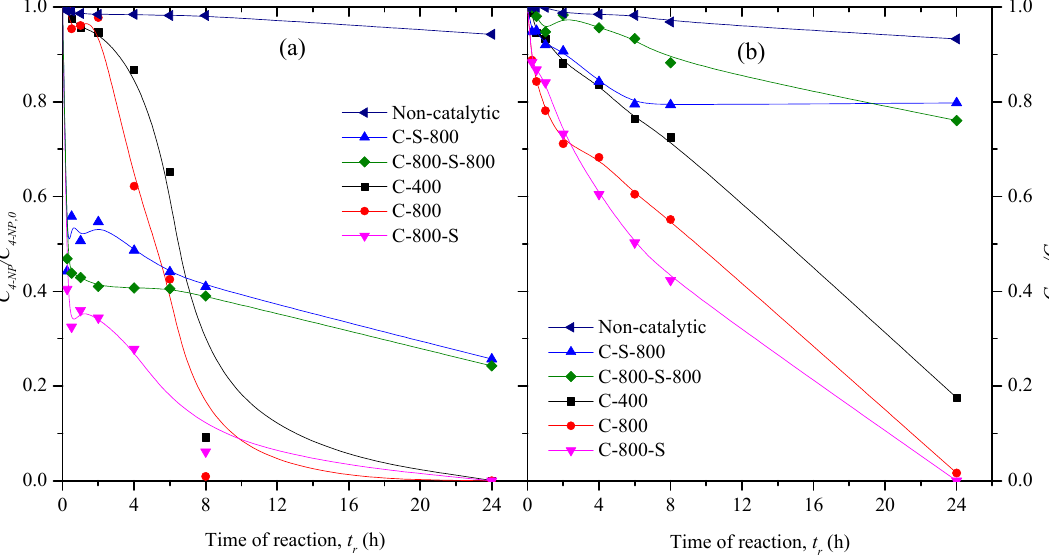
Figure 5. Concentration decay curves of 4 ‐ NP ( a ) and H 2 O 2 ( b ) in the CWPO of 4 ‐ NP carried out with the thermally treated materials. Operating conditions: 50 °C, pH 0 = 3, C cat = 2.5 g L − 1 , C 4 ‐ NP,0 = 5.0 g L − 1 , and the stoichiometric quantity of H 2 O 2 needed for the total mineralization of 4 ‐ NP.